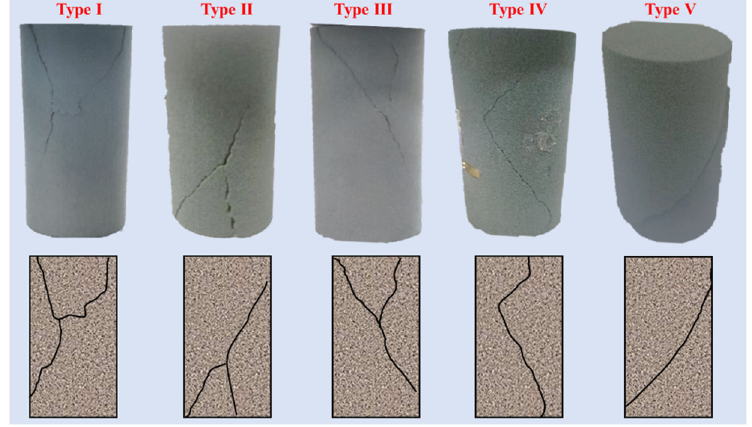
Figure 10. Pictures and re-drawn schematic of the failure pattern of the 3DP rock analogs printed with different blends of sand